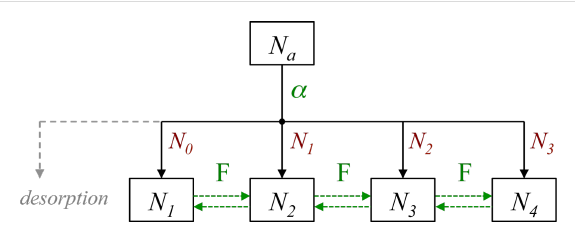
Figure 15: Flowchart showing how F radicals (represented by α ) generated by electron induced dissociation of NF 3 adsorbates (repre- sented by the adsorbate concentration N a ) are converted into SiF n ( N n ) by reacting with SiF n − 1 ( N n − 1 , shown in red). Horizontal green arrows indicate conversion of SiF n species by the addition and removal of F. The flowchart illustrates why m in Equation 57 ranges from 0 to 3 (corresponding to N n − 1 , shown in red), and why n in Equation 58 ranges from 1 to 4 (corresponding to N n , shown in black).